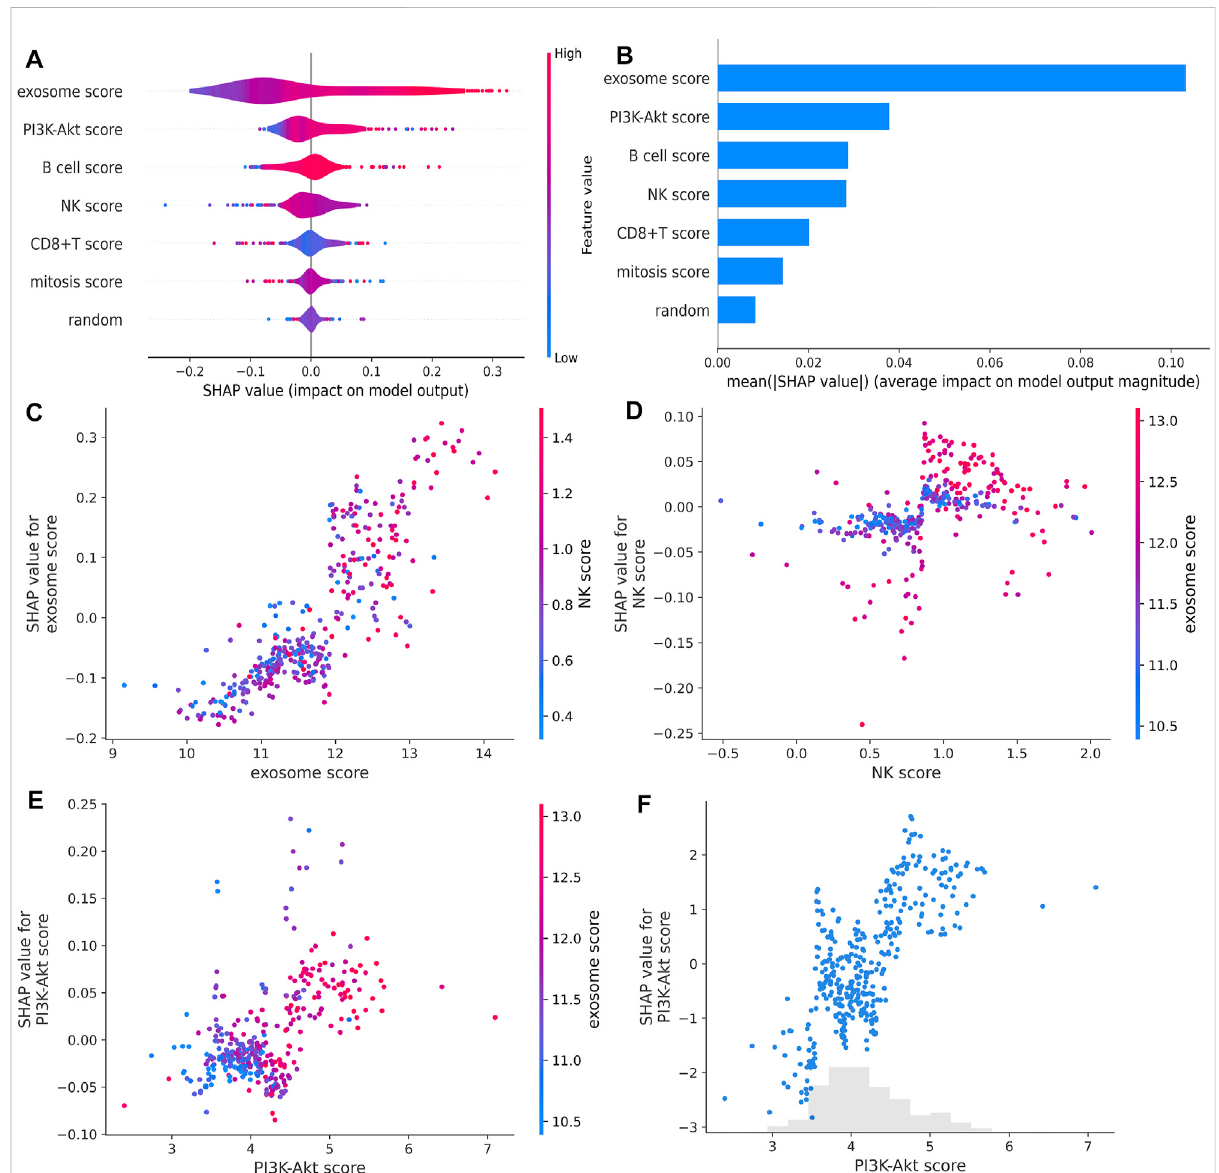
FIGURE 5 RF feature importance and interactions. (A,B) RF feature importance compared with randomly generated numbers estimated with SHAP. (C,D) Impact of the interaction between the exosome score and NK score estimated with SHAP. (E) Impact of the interaction between the PI3K-Akt score and exosome score estimated with SHAP. (F) PI3K-Akt score for each patient in TCGA estimated with